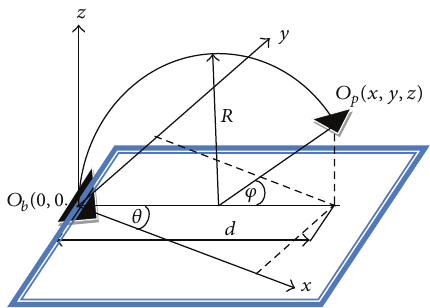
Figure 2: Proposed model bending